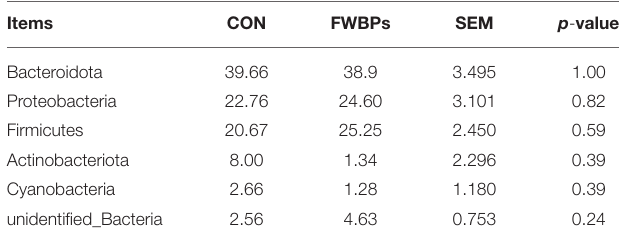
TABLE 7 | Effects of FWBPs on the ruminal microbiota of early-weaned lambs (phylum level)